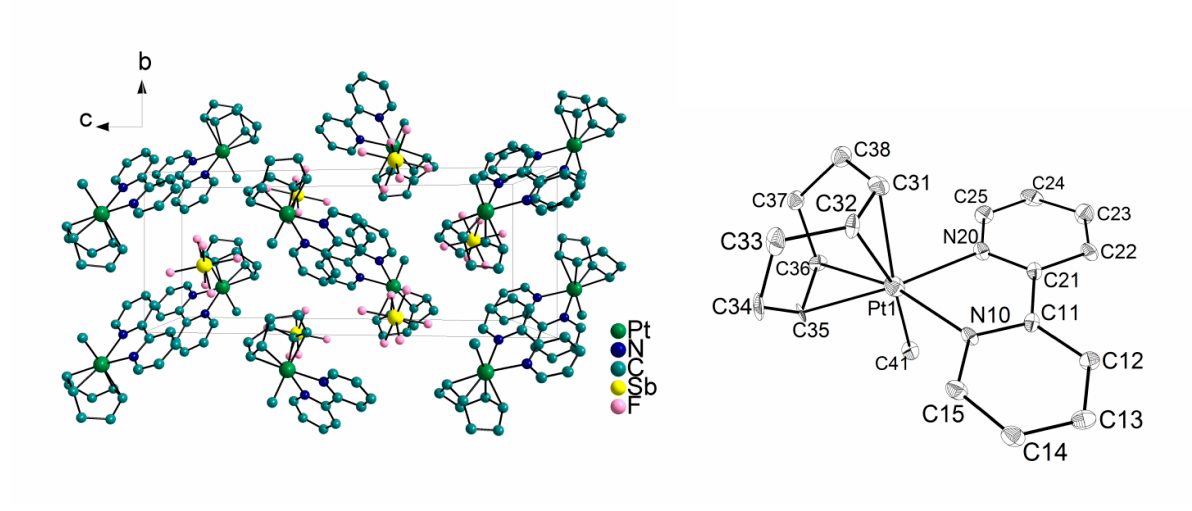
Figure 1. Crystal structure of [Pt(bpy)(cod)(Me)][SbF 6 ] (bpy = 2,2’-bipyridine, cod = 1,5-cyclooctadiene) ( left ; viewed along the crystallographic a axis) and the molecular structure of the complex cation (right ; at 50% probability level (with numbering); protons were omitted for